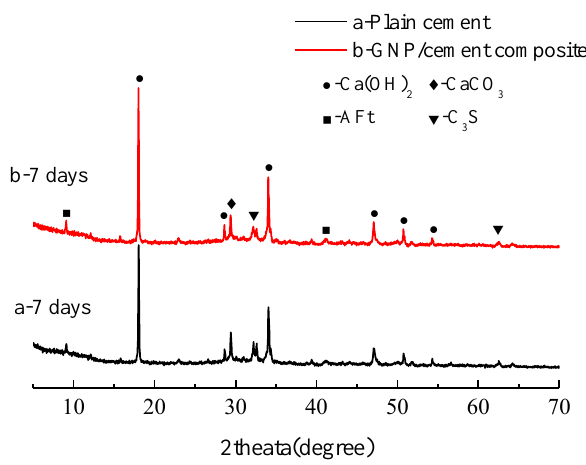
Figure 5. X-ray diffraction (XRD) patterns of ( a ) plain cement paste and ( b ) GNP-cement composite at the age of 7 days.